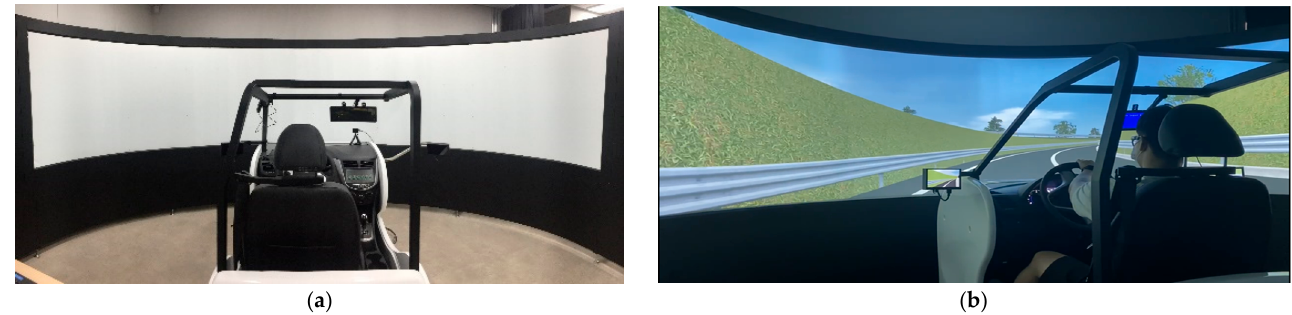
Figure 1. Location of study sites and the signs on the segments for experiments: ( a ) driving simulator; ( b ) driving simulator during experiment.